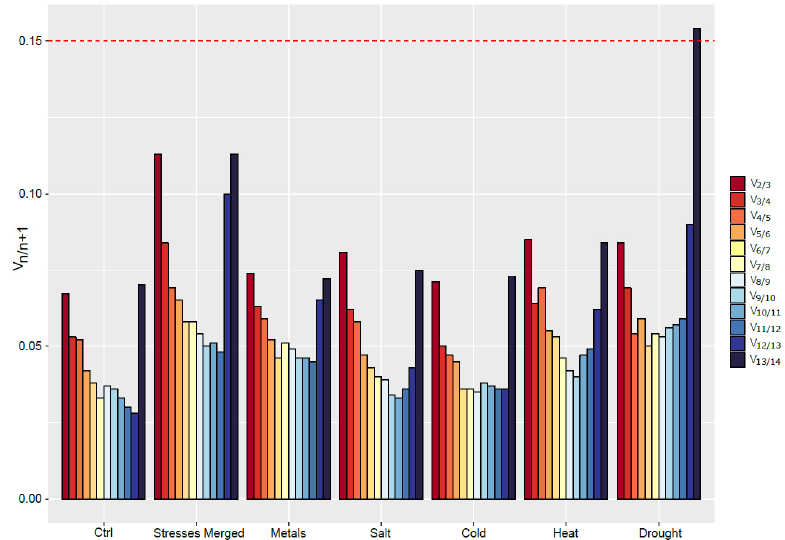
Figure 3. Determination of the appropriate number of RGs to use for data normalization in S. viminalis roots under various abiotic stresses conditions (metal, salt, cold, heat, drought) as computed by geNorm PLUS . The recommended threshold of 0.15 (red dashed line) was kept in this